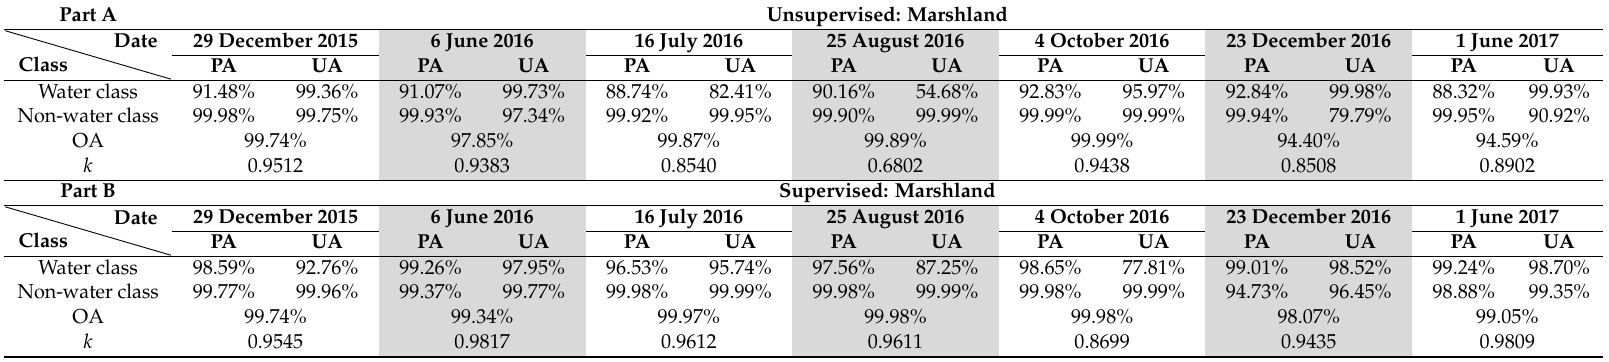
Table 5. Part A and Part B show for the marshland the accuracy assessment results for the unsupervised and supervised approaches, respectively. Part